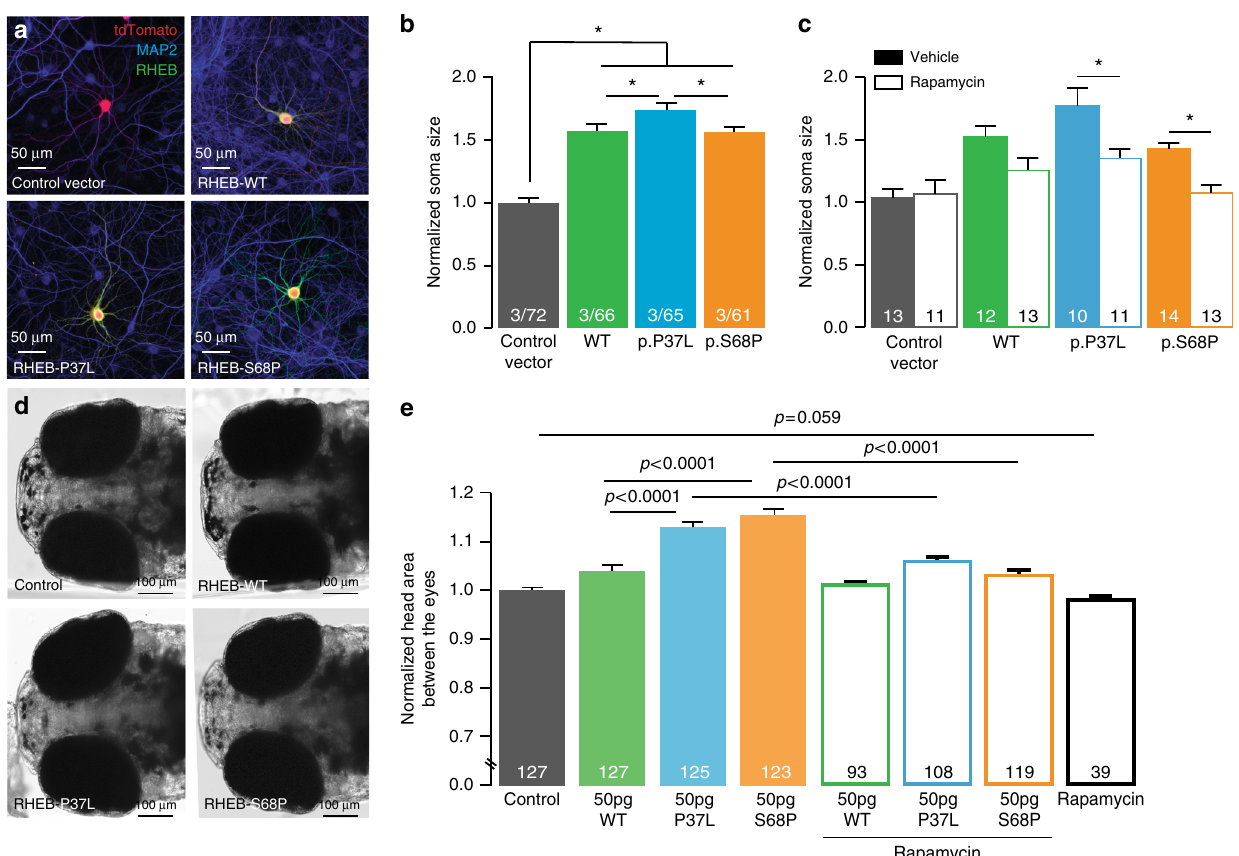
Fig. 3 De novo mutations in RHEB increase soma size and headsize, phenotypes that can be rescued by rapamycin. a Representative confocal images of hippocampal neurons transfected with control vector, RHEB-WT, RHEBp.P37L or RHEBp.S68P. b Summary bar graph of soma size measured for each condition and normalized to the control vector. c Summary bar graph of soma size measured with and without rapamycin. Data are presented as mean ± SEM. Numbers depicted in the bar graph in b represent the number of independent cultures/total number of cells analyzed and in c number of cells analysed. Statistical signi fi cance was assessed by one-way ANOVA followed by Tukey ’ s post hoc test (* p < 0.01). d Dorsal view of 5 dpf control and overexpressant zebra fi sh larvae. For each experiment, embryos were injected with either WT or mutant RHEB human mRNA message. The area between the eyes was measured for every embryo, to produce a quantitative score. e Bar graph showing the quanti fi cation of the headsize phenotype in control embryos and embryos injected with either WT or mutant human RHEB with and without rapamycin. The graph represents cumulative plotted experiments across three biological replicas. Statistical analyses were performed by Student ’ s t of PI3K-AKT-mTOR than RAS-MAPK-mTOR with ICV (PI3K-